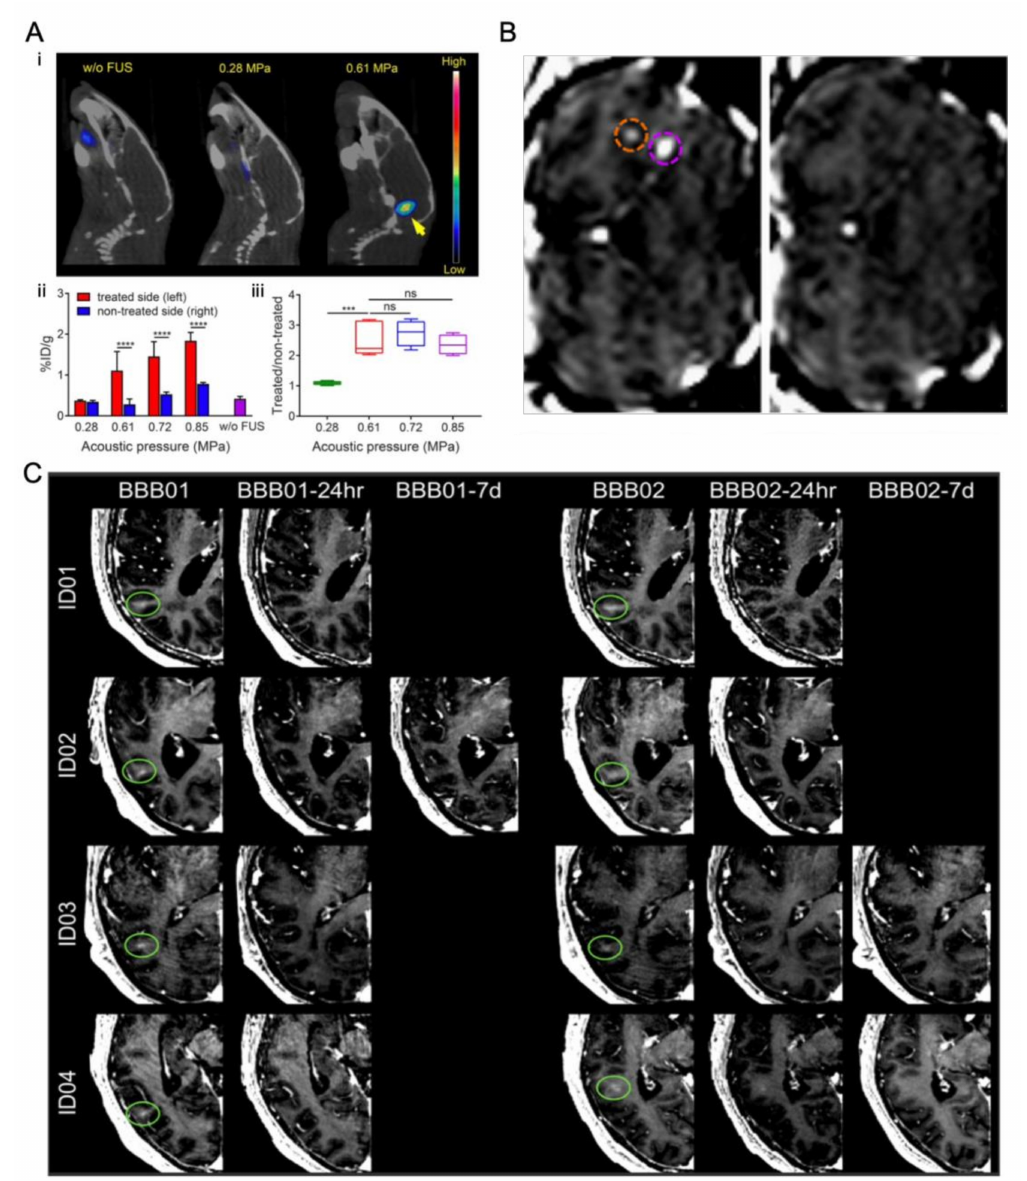
Figure 7. Representative studies for BBB opening by ultrasound-driven microbubbles in vivo. ( A ) ( i ) In vivo PET/CT images of 64 Cu-CuNCs without focused ultrasound (FUS) treatment